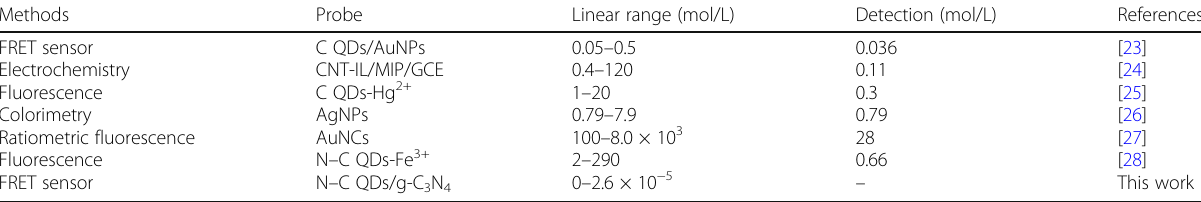
Table 1 The different fluorescence methods for the detection of melamine Methods